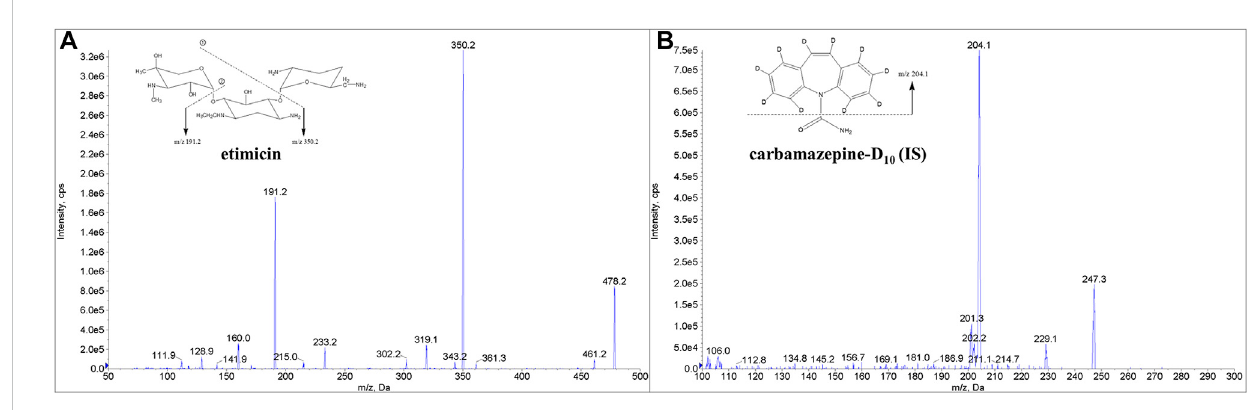
FIGURE 1 Chemical structures and mass spectra of etimicin (A) and the IS (B) .